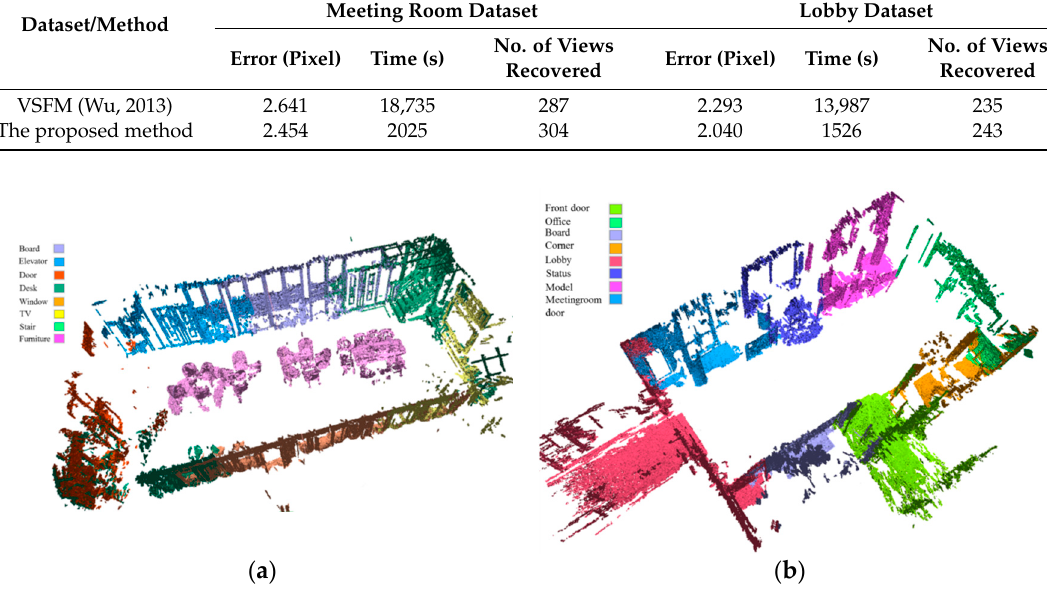
Figure 8. The partial semantic segmentation result on 2D images of the meeting room. The first row shows the input images, while the second row are the corresponding semantic segmentation results.